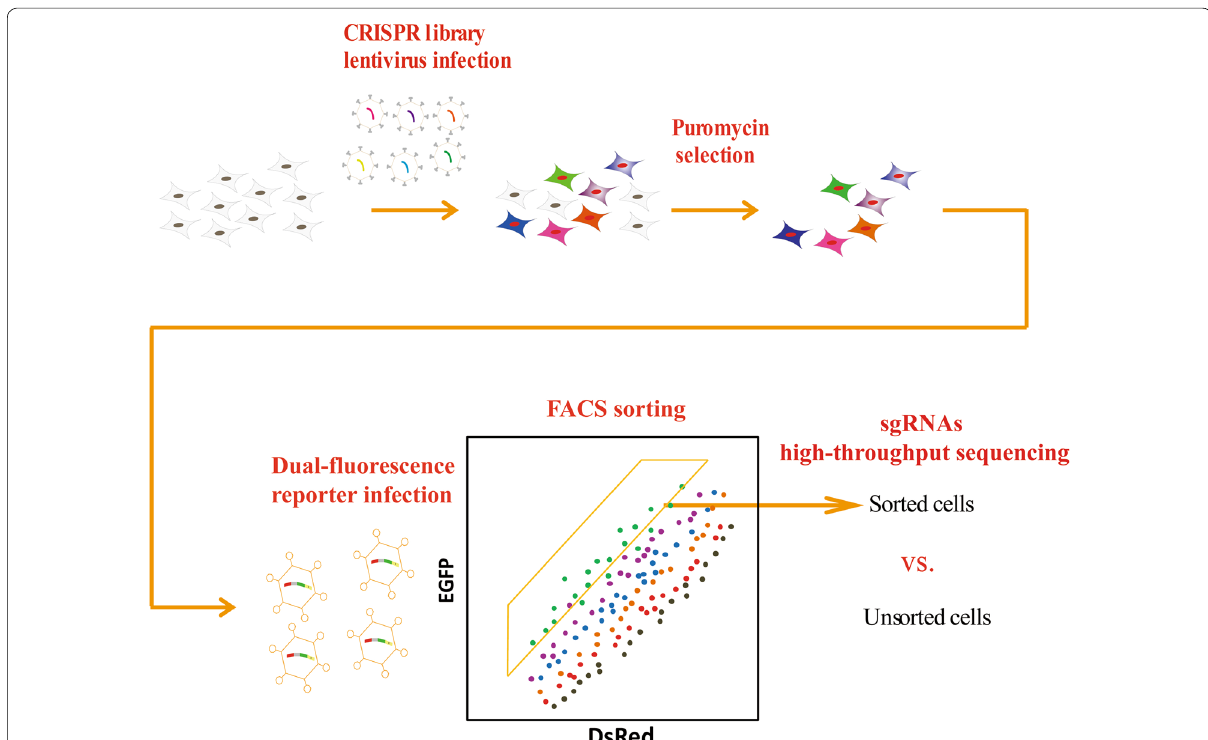
Fig. 1 The workflow of the protein stability regulators screening assay (Pro-SRSA). CRISPR clustered regularly interspaced short palindromic repeat, FACS fluorescence-activated cell sorting, EGFP enhanced green fluorescence protein, DsRed Discosoma sp. red fluorescent protein, sgRNA single- guide